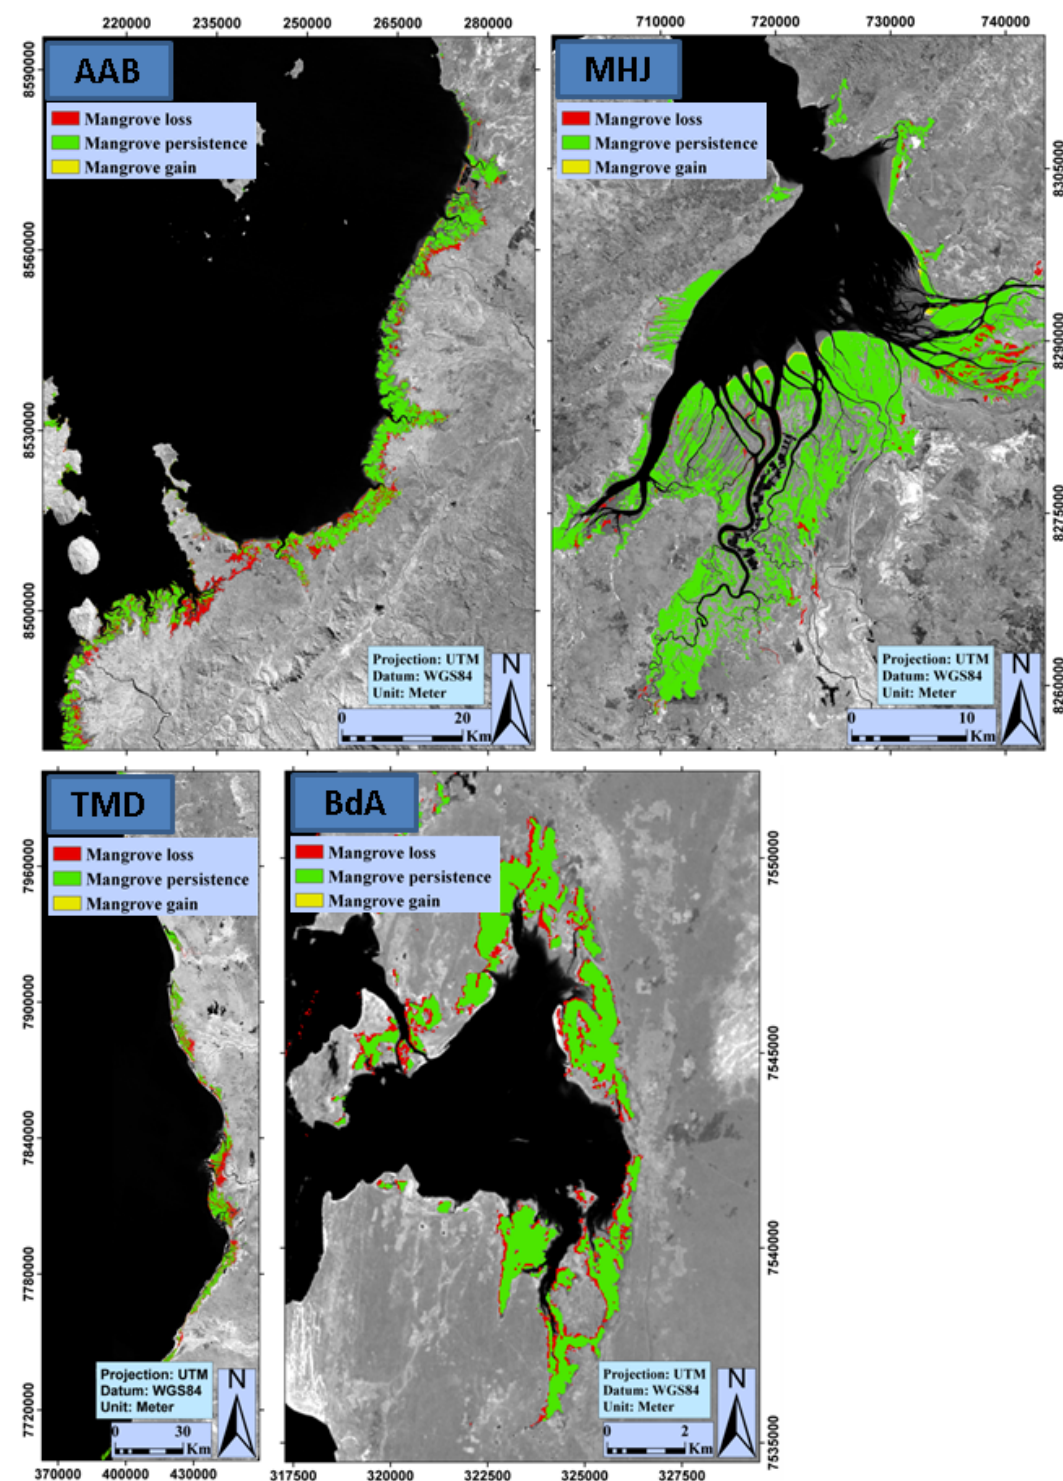
Figure 5. Dynamics from 1990 to 2010 for each of four AOIs calculated using the USGS-produced, Landsat-derived mangrove cover maps for 1990, 2000 and 2010 [69]. Background images are Landsat NIR bands from AOI-specific dates provided in Table 1.